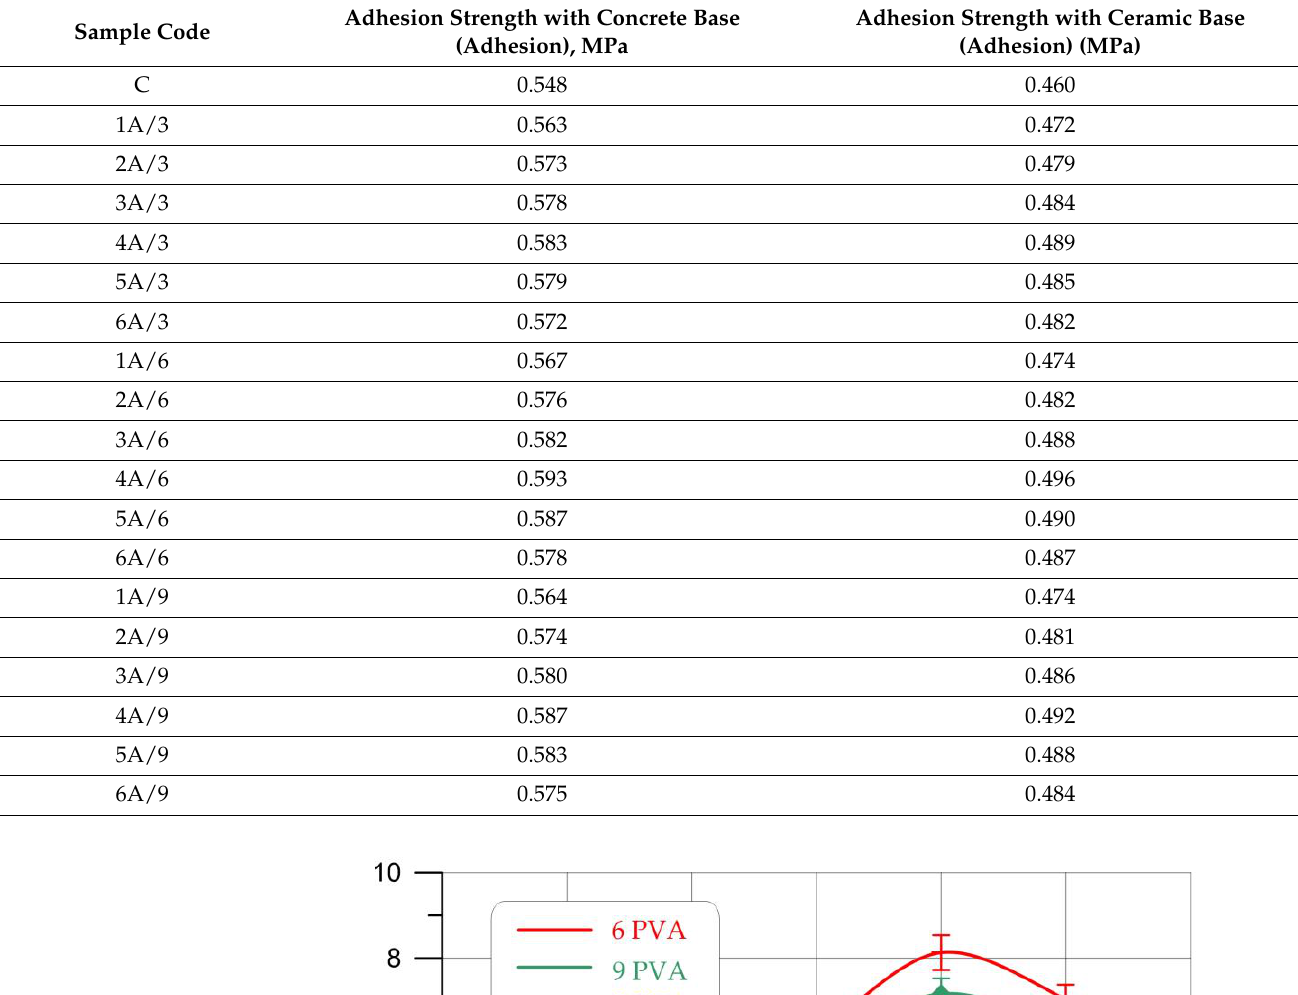
Table 8. Adhesion of geopolymer composites.